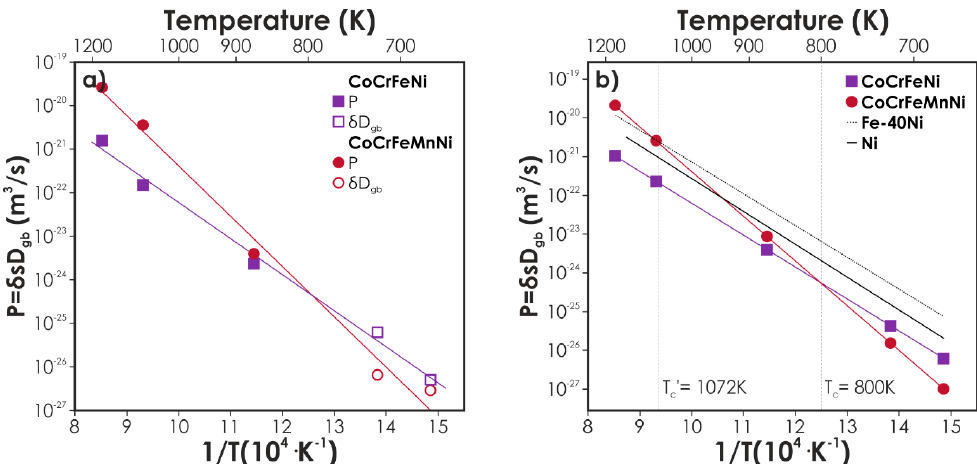
Figure 6. ( a ) Arrhenius plots of Ni grain boundary (GB) diffusion in CoCrFeNi and CoCrFeMnNi measured in B- (solid symbols) and C-type (open symbols) kinetic regimes. The width of the GB ( δ ) was taken as 0.5 nm. ( b ) Comparison of GB diffusivities of Ni in CoCrFeNi, CoCrFeMnNi, with pure Ni and Fe-Ni alloy (after [32]).